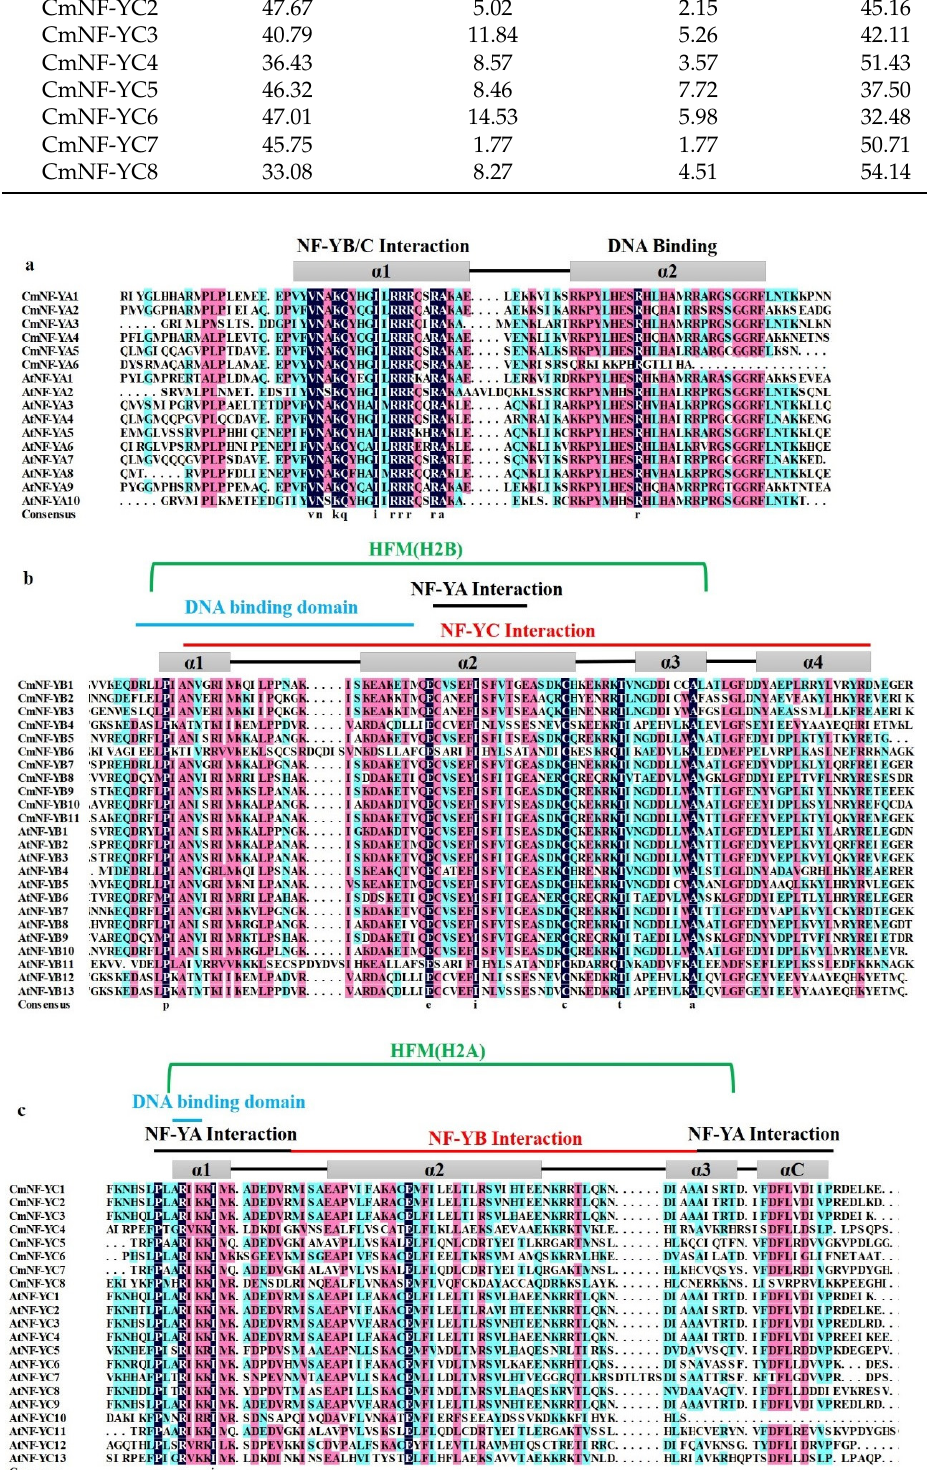
Figure 3. Alignments of CmNF-Y and AtNF-Y domains. The sequences of melon NF-YAs ( a ), NF-YBs ( b ), and NF-YCs ( c ) were aligned with corresponding referred sequences from Arabidopsis thaliana . The different colors represent the level of sequence homology, with black ≥ 100%, purple ≥ 75% and blue-green ≥